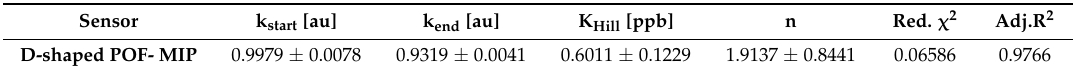
Table 2. Hill parameters (D-shaped POF platform with MIP).